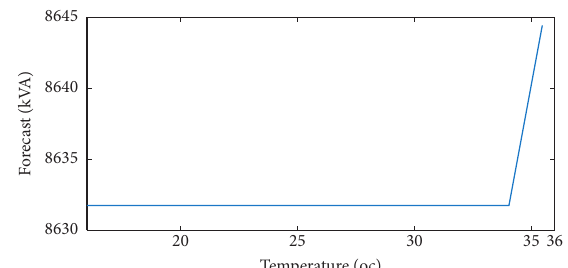
Figure 28: Correlation between forecast load and temperature for total system load.